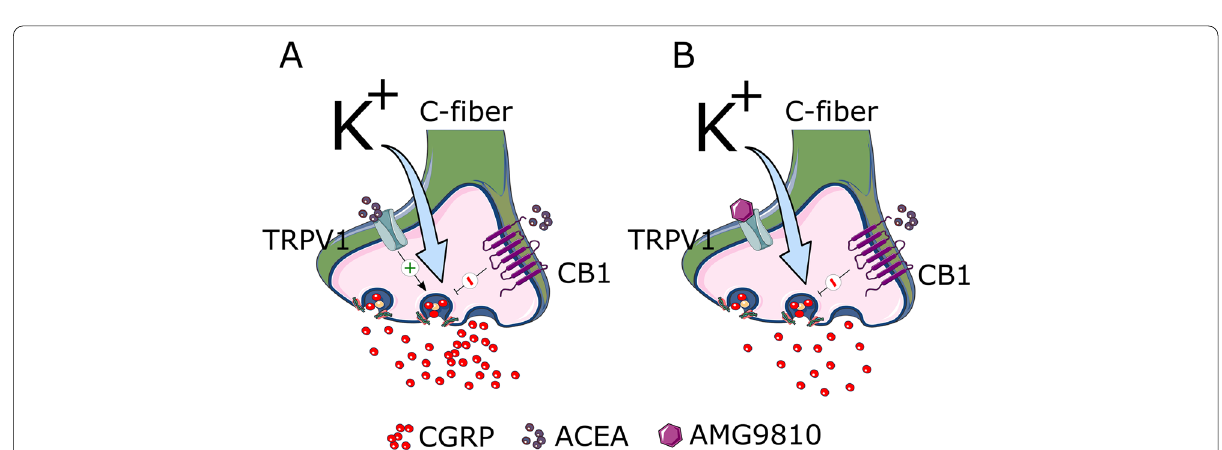
Fig. 6 Graphical illustration of the interaction of CB1 and TRPV1 by cannabinoids. A ACEA activates both TRPV1 and CB1 in a native setting, leading to no observed inhibition. B when TRPV1 is inhibited, activation of CB1 leads to an attenuation of the CGRP